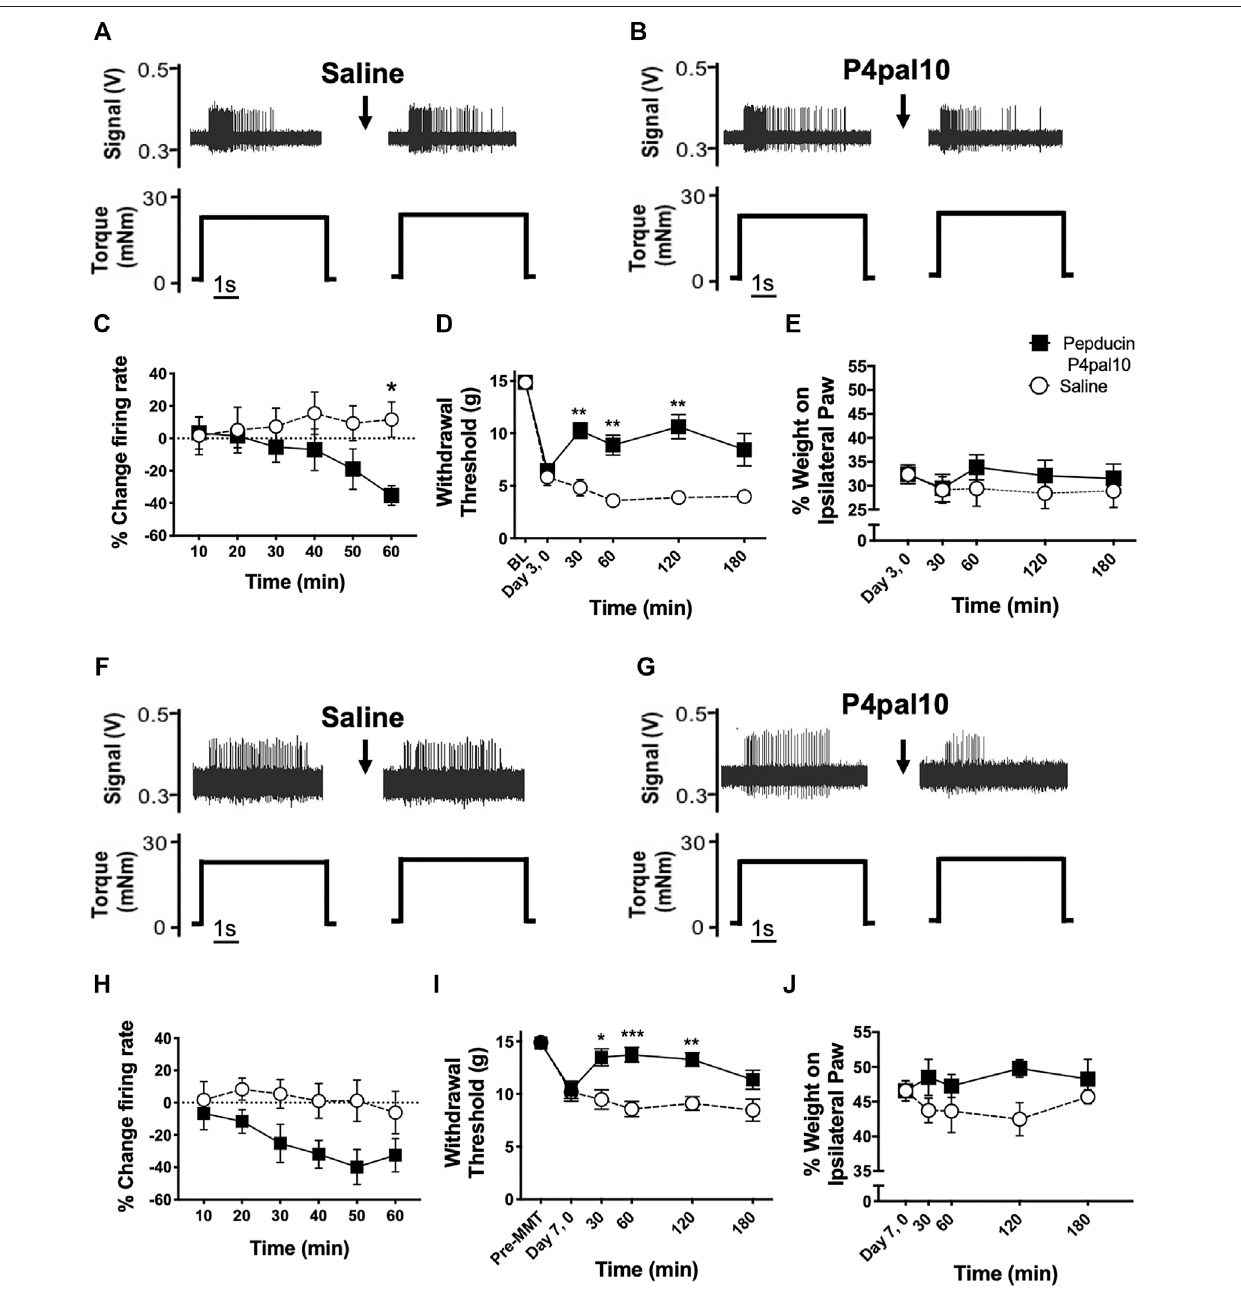
FIGURE 5 | Effect of PAR4 blockade on Early OA/PTOA Pain Behaviour and Joint Electrophysiology. Representative traces of knee joint afferent recordings from day 3 MIA animals (A – B) and day 7MMT animals (F – G) before and after administration of saline or pepducin P4pal10. Evoked fi ring is in response to noxious rotation of thekneejoint.SystemicadministrationofpepducinP4pal10reducedafferent fi ringrelativetobaselineovera60 mintimecourseinbothday3MIA (C) andday7MMT (H) jointafferents( n (cid:1) 8 – 10 fi brespergroup,2-wayRM-ANOVA).AdministrationofpepducinP4pal10improvedwithdrawalthresholdsfor120 mincomparedtosaline vehicleinday3MIAanimals (D) ( p < 0.001,2-wayRM-ANOVA, n (cid:1) 7). Weightbearing de fi citswerenotimprovedfollowingdrugadministration (E) ( p > 0.05,2-wayRM- ANOVA, n (cid:1) 7). When day 7 MMT animals were treated with pepducin P4pal10, both secondary allodynia (I) and weight bearing de fi cits (J) were improved ( p < 0.05 – 0.001, 2-way RM-ANOVA, n (cid:1) 7). * p < 0.05, ** p < 0.01 *** p < 0.001, **** p < 0.0001 denotes statistical signi fi cance using post hoc Sidak ’ s Multiple Comparisons Test. Data presented as means ± SEM.